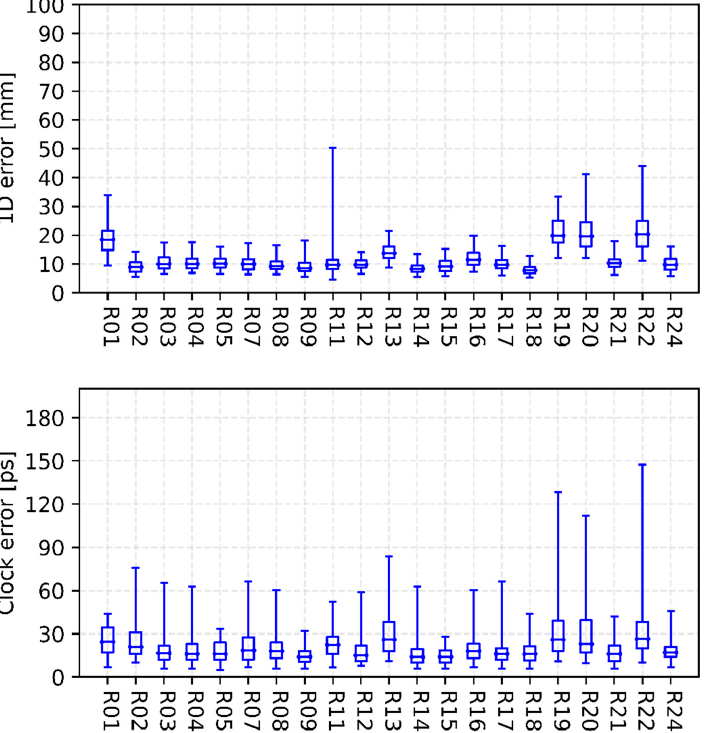
Figure 4. Internal precision of iGMAS final combined GLONASS orbit ( top panel ) and clock ( bottom panel ).